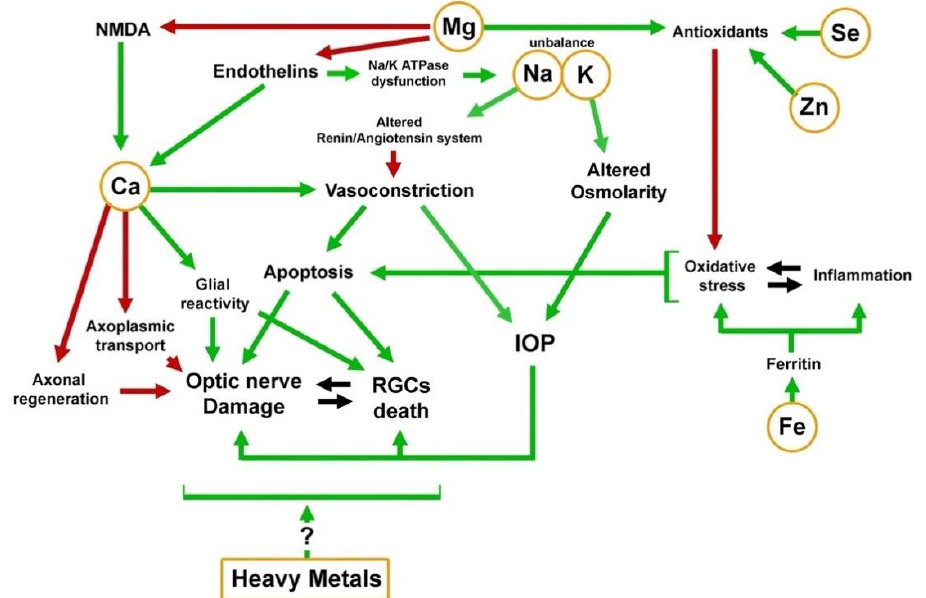
Figure 2. Mechanistic scheme of the activity of elements in the pathological background of glaucoma. Green arrows indicate involvement of the element in activational process; Red arrows indicate inhibition.